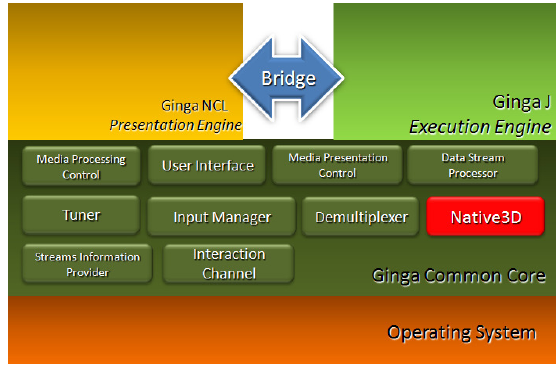
Figure 3. Native3D module in Ginga Common Core to support 3D